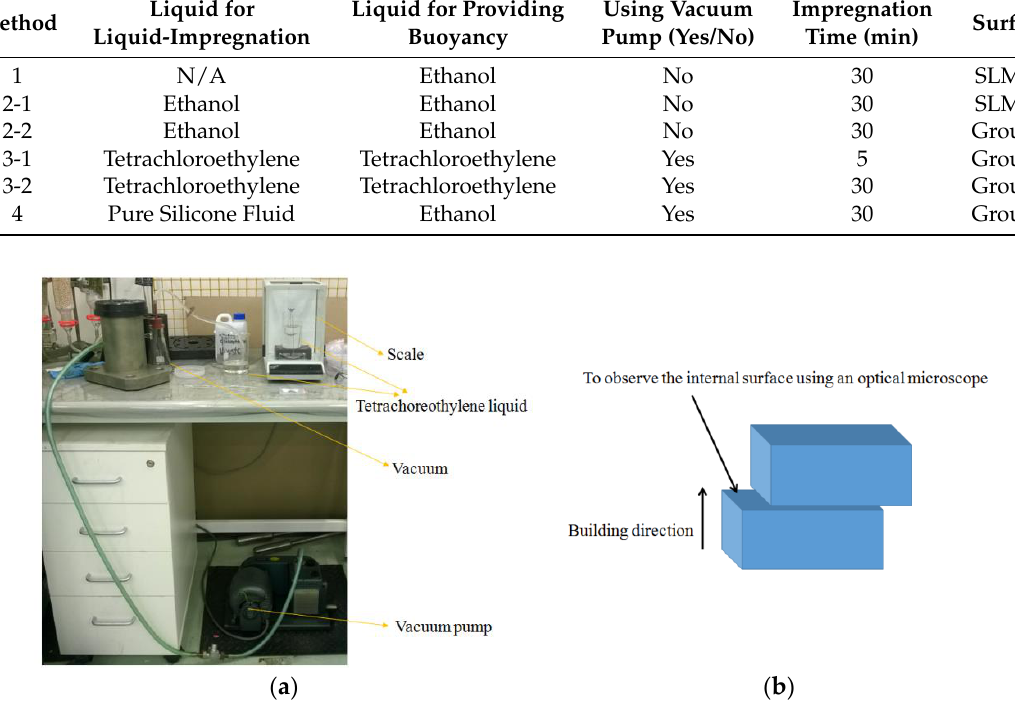
Figure 1. Test methods and equipment. ( a ) The Archimedes method equipment; ( b ) the cutting direction and the observed cross section in the samples for image analysis.